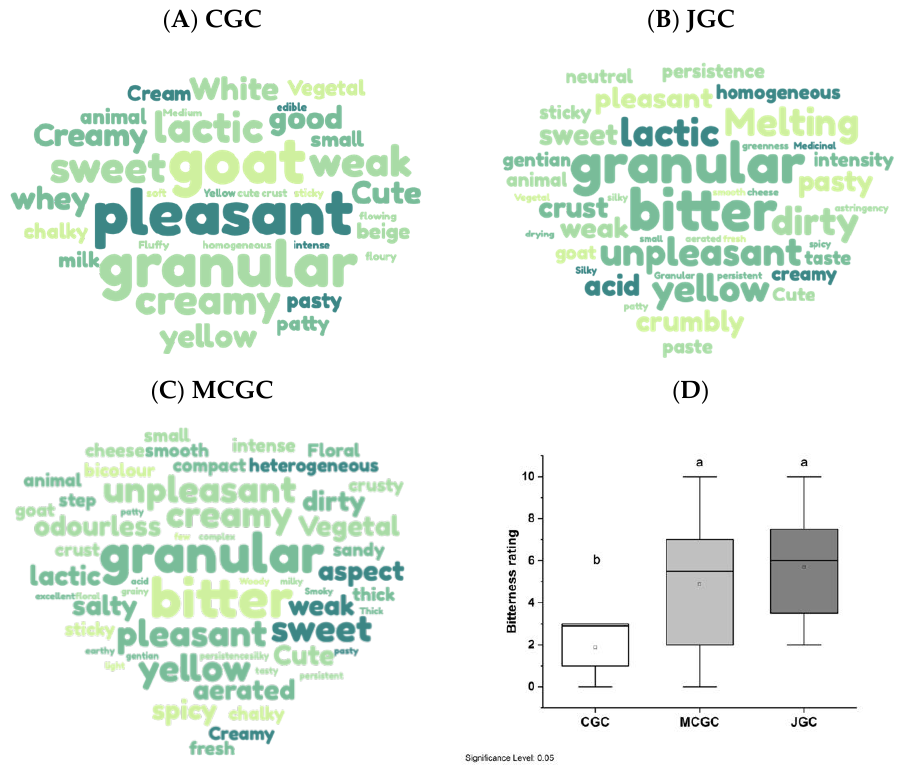
Figure 3. Free descriptors associated with unflavored goat cheese ( A ) and flavored goat cheeses elaborated with Gentiana lutea rhizomes originating from Massif Central ( B ) and Jura ( C ). The bigger the word, the more the descriptor was cited by cheese tasters, between 2 times and 16 times among the whole panel. Histogram of bitterness rating of flavored and unflavored goat cheese evaluated by the panelists (n = 17) ( D ). Letters indicate the significant difference based on mean comparison with the Friedman test applied for each tasted cheese (alpha = 5%).